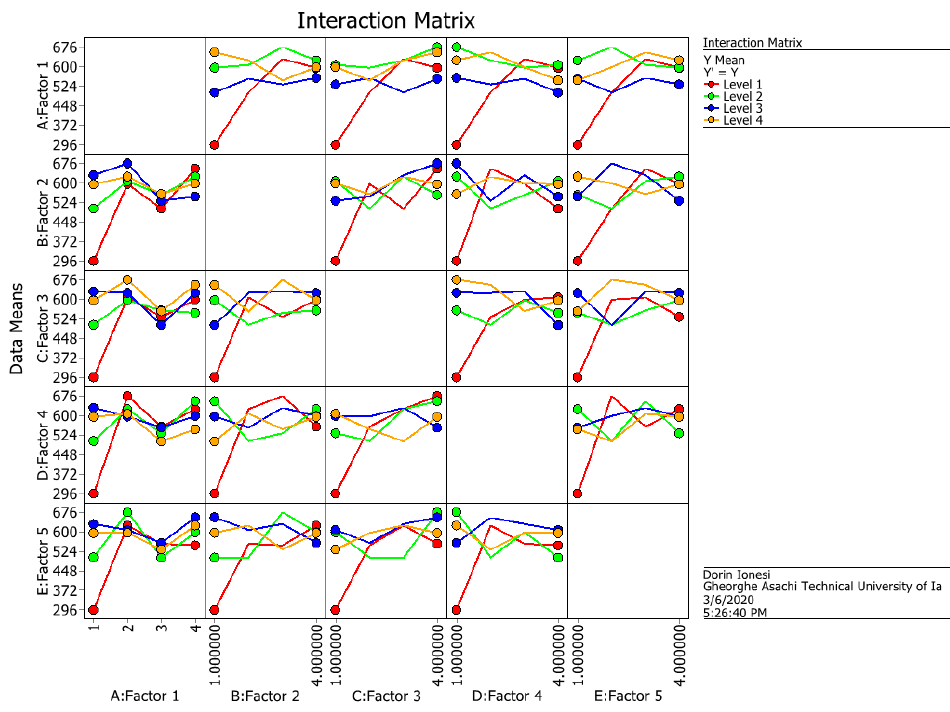
Figure 9. The interactions between factors for means.